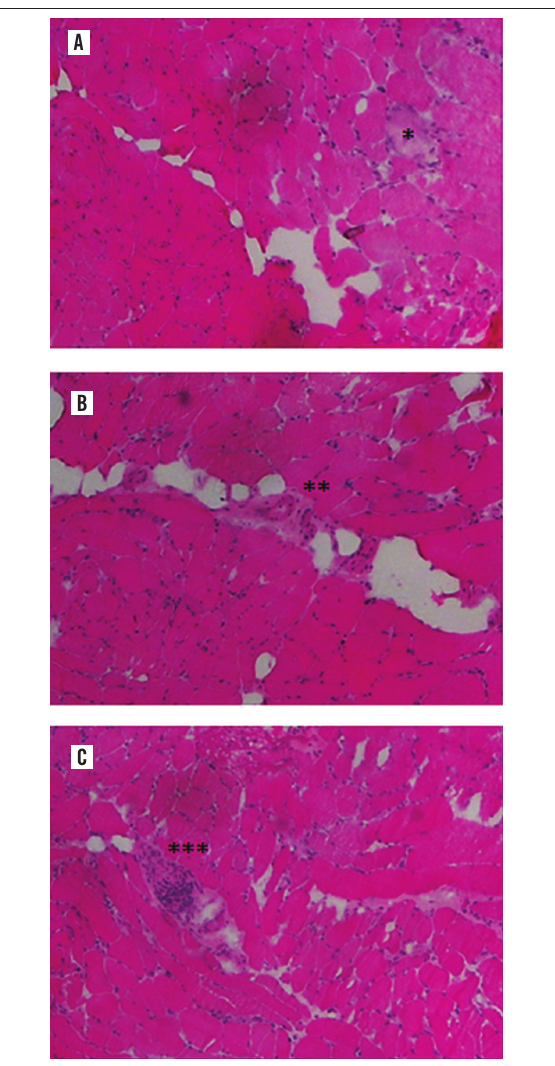
figurE − Histological section of three distinct levels of the same muscle biopsy block from a DM patient. A) Presence of a necrotic muscle fiber is noticed (*); B) the necrotic muscle fiber is no more observed, but the presence of capillaries at a perimysial region (**); C) an intense inflammatory infiltrate is perceived around these capillaries (***). HE staining, 200× magnification DM: dermatomyositis; HE: hematoxylin and